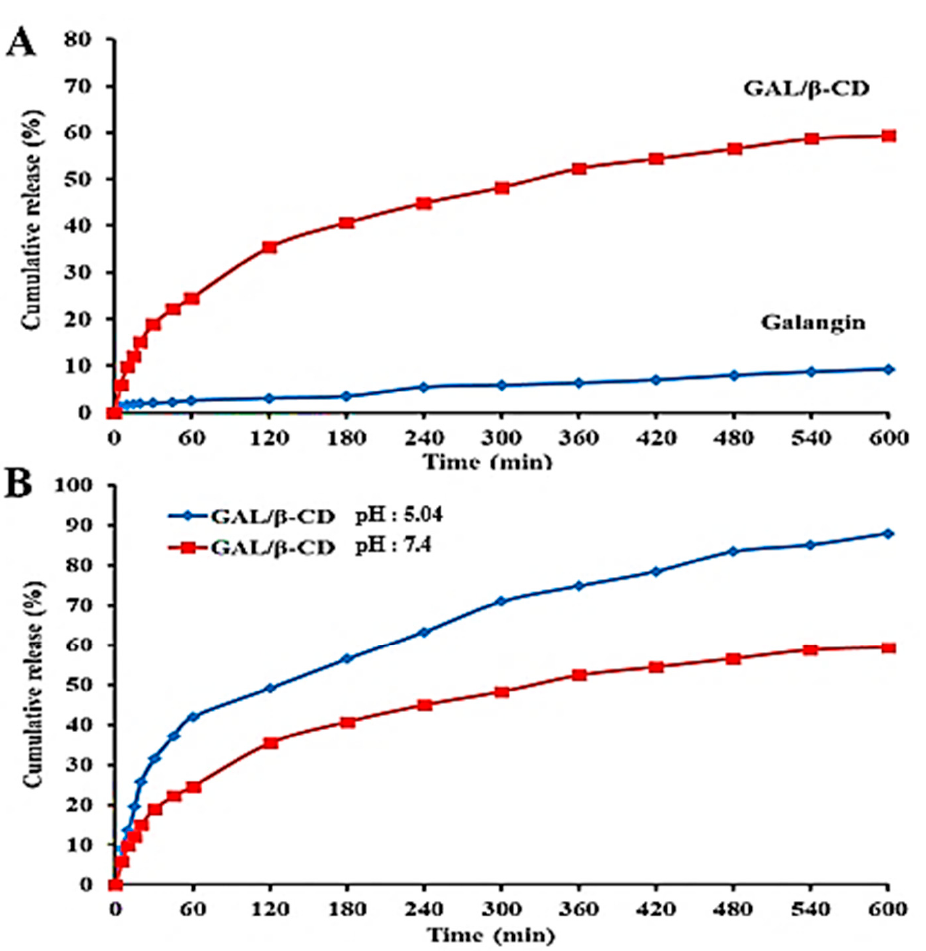
Figure 2. Release profile of ( A ) galangin and modified GAL/ β -CD in PBS at pH 7.4 and ( B ) modified GAL/ β -CD in PBS at pH 7.4 and 5.04.